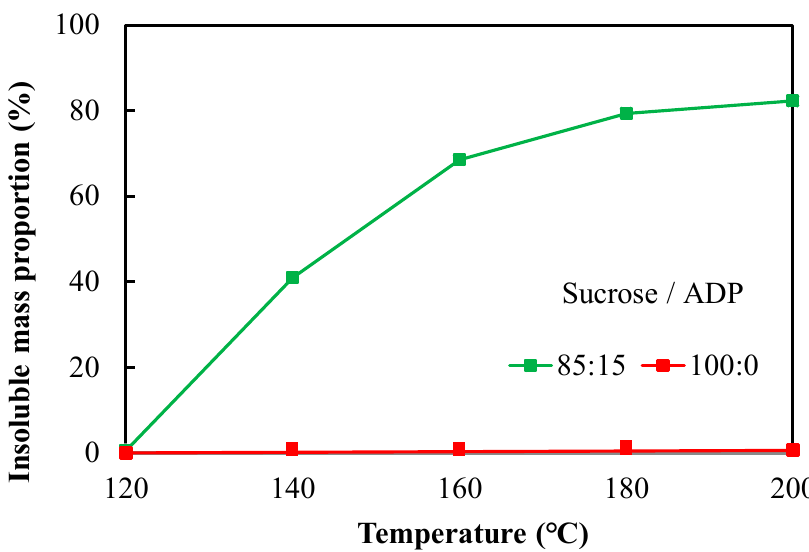
Figure 7. Insoluble mass proportion of SADP 85/15 adhesive and sucrose under different temperatures.